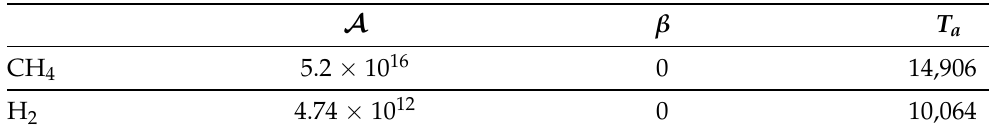
Table 1. Kinetics parameters of the two combustion reactions. CH 4 indicates the combustion of the methane, whereas H 2 the combustion of the hydrogen.